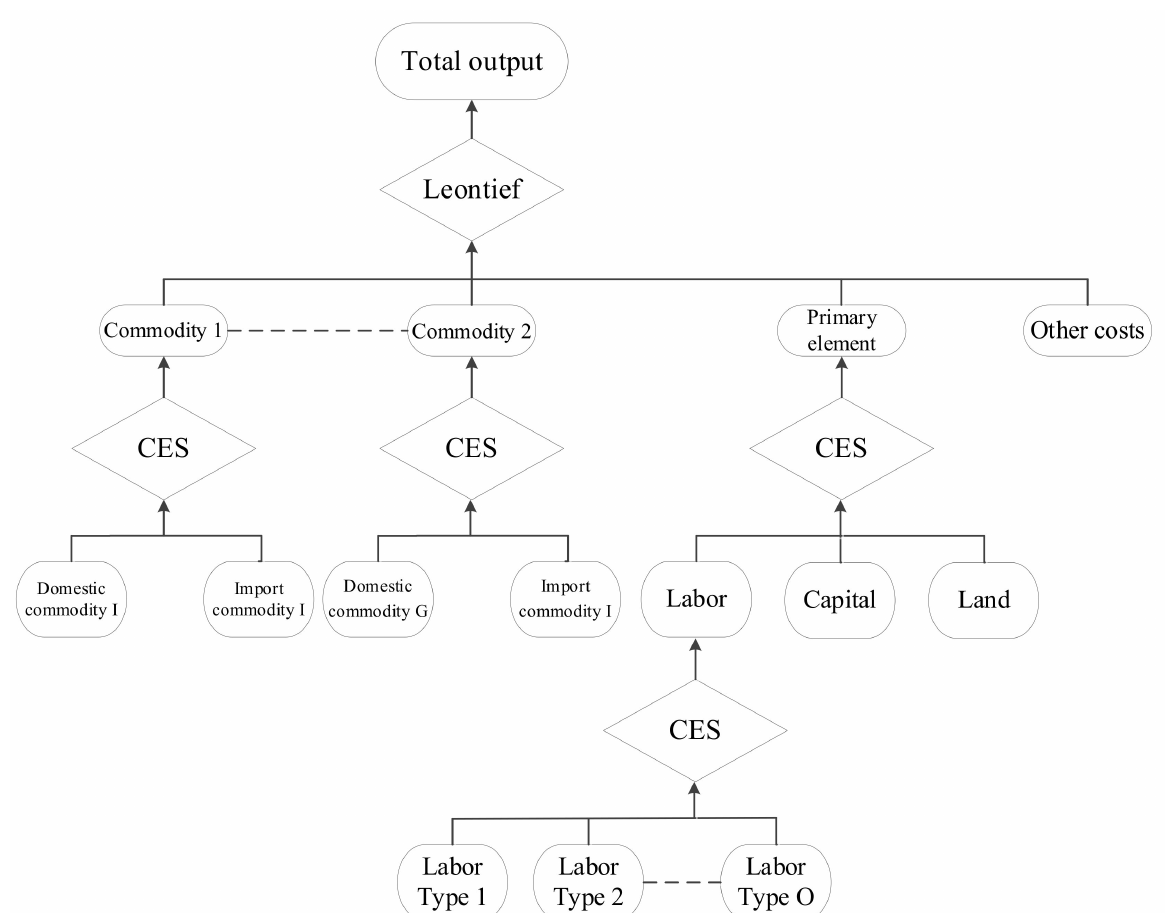
Figure 4. Production module of the CGELUC